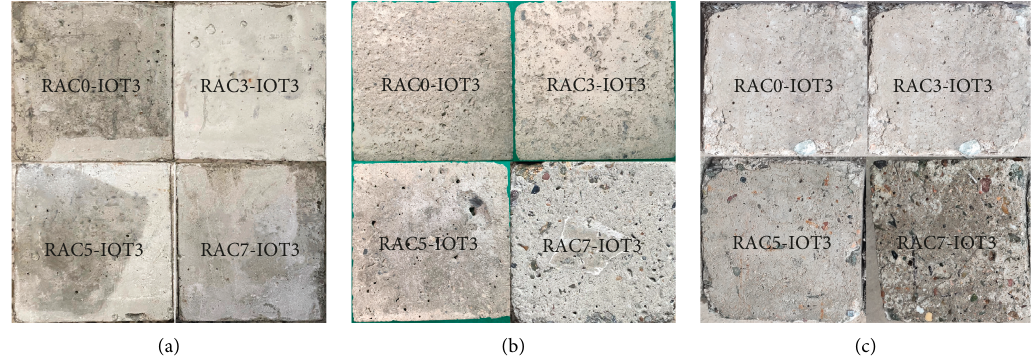
Figure 6: Apparent phenomenon of concrete specimens: (a) F-T cycle 0 times; (b) F-T cycle 100 times; (c) F-T cycle 200